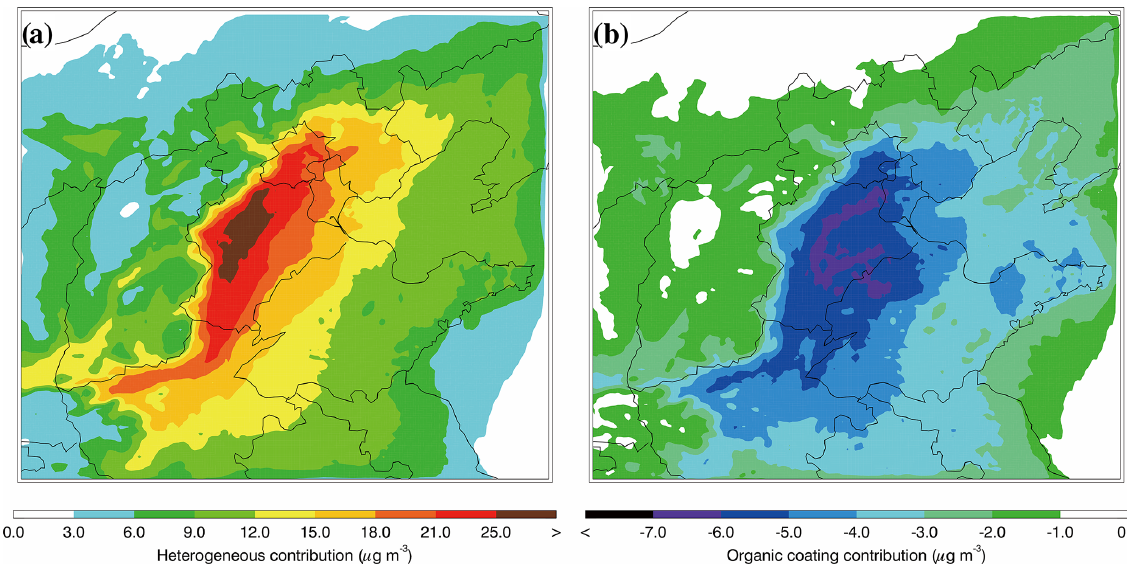
Figure 9. Spatial distributions of average nitrate contributions of (a) the N 2 O 5 heterogeneous hydrolysis and (b) organic coating in BTH from 10 to 27 February